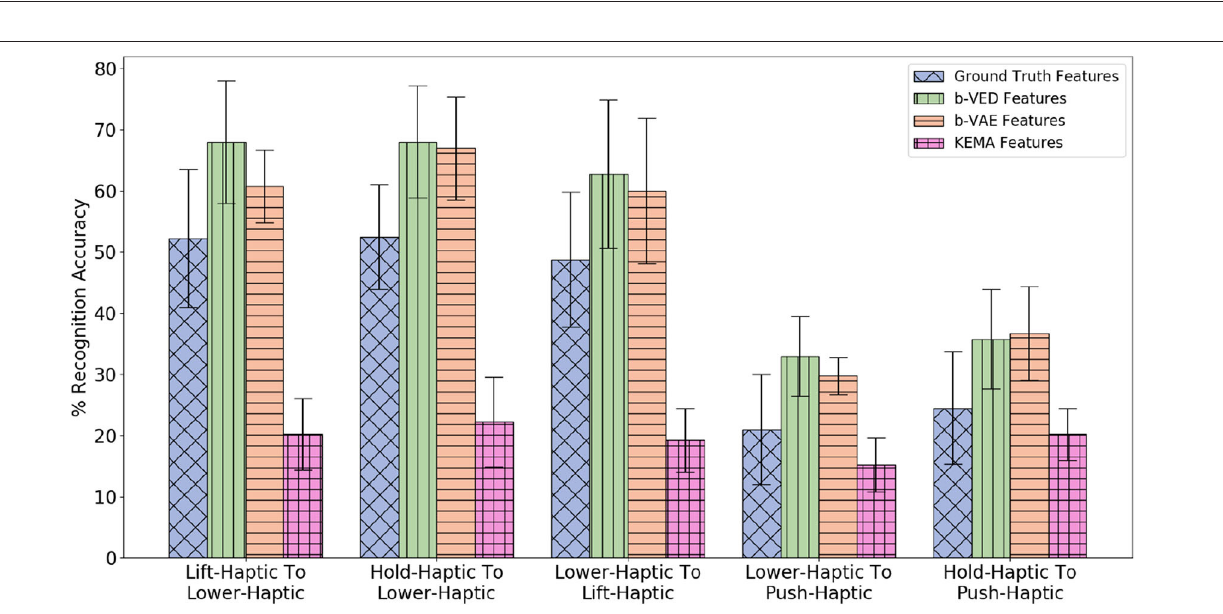
FIGURE 23 | β -VED cross-behavior projections where the Accuracy Delta is minimum and corresponding β -VAE projections and KEMA projections for the dataset in Sinapov et al.